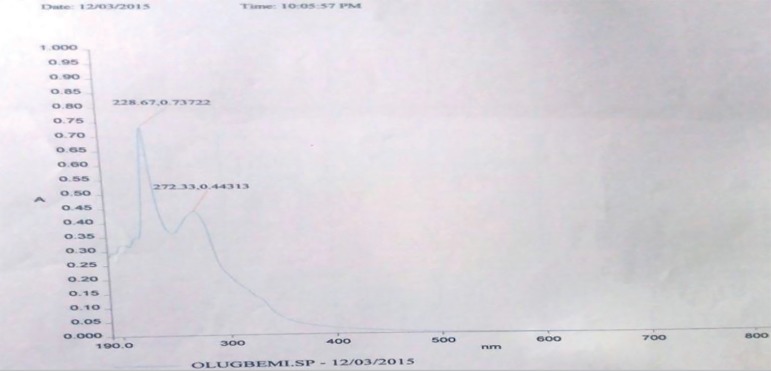
Ultraviolet (UV) spectrophotometry analysis of the flavonoid
fraction